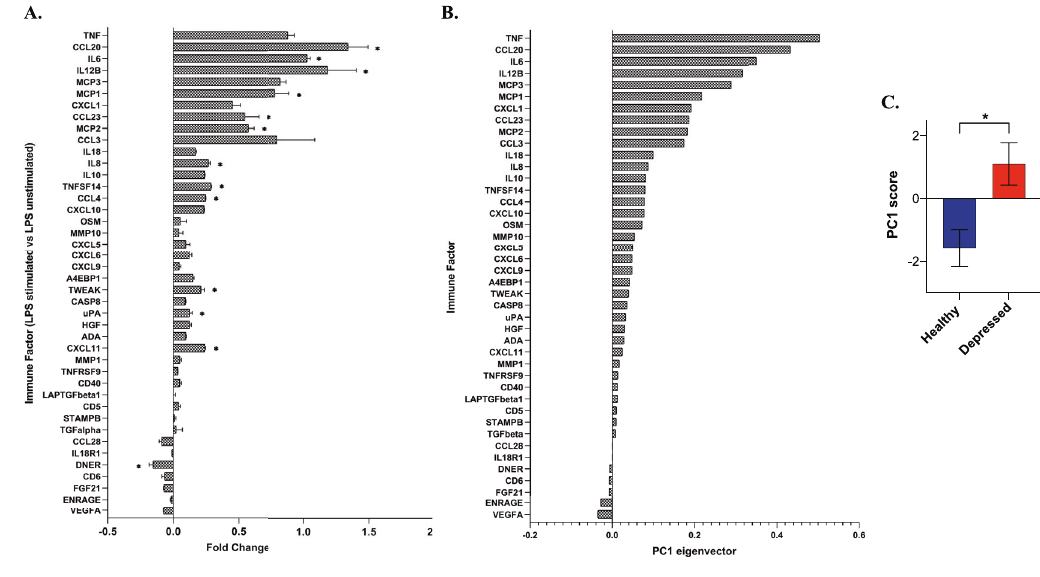
Fig. 1 Heightened peripheral blood mononuclear cells reactivity in depression. A Difference in fold change of levels of lipopolysaccharide (LPS) stimulated immune factors released ex vivo by peripheral blood mononuclear cells (PBMCs) between depressed and healthy volunteers - uncorrected t -test. B Principal component 1 (PC1) factor loading. PC1 explained a large proportion of the variance, with an eigenvector of 12.6, accounting for 52.8% of the total variance in the data and included highest factor loadings for tumor necrosis factor alpha (TNF-alpha), chemokine ligand 20 (CCL-20), interleukin-6 (IL-6), interleukin-12 subunit beta (IL-12B), and monocyte-chemotactic protein 3 (MCP3). C Immune reactivity PC1 score difference between depressed subjects and healthy volunteers; * p < 0.05, error bars represent standard error of the mean (SEM).